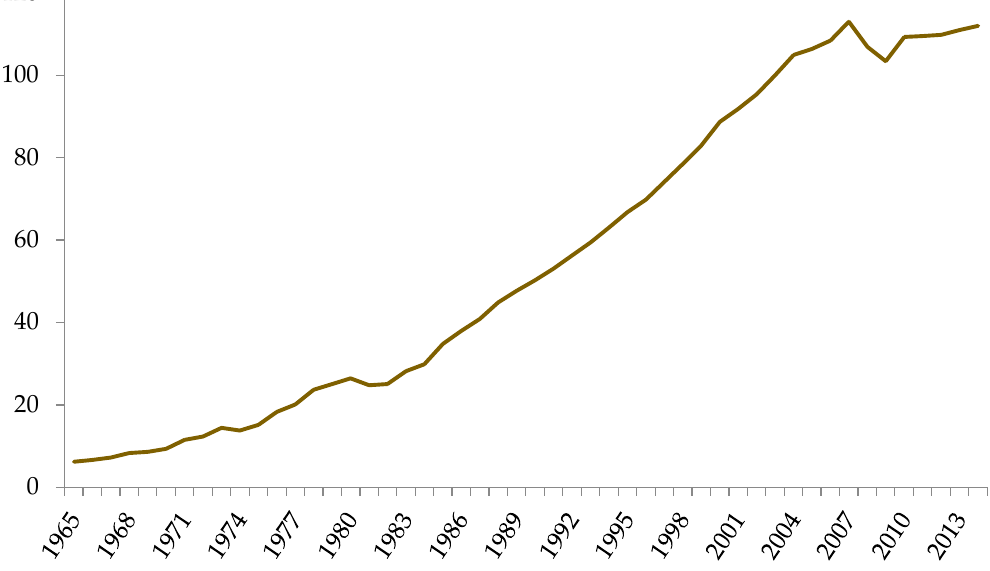
Figure 2. Taiwan’s primary energy consumption (million barrels of oil equivalent). Source: BP Statistical Review of World Energy 2015.